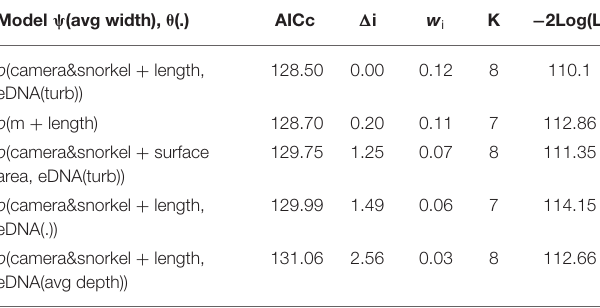
TABLE 2 | Summary of the model selection using AIC for the occupancy and detection probability of redfins using underwater cameras, snorkel surveys, and combined eDNA.